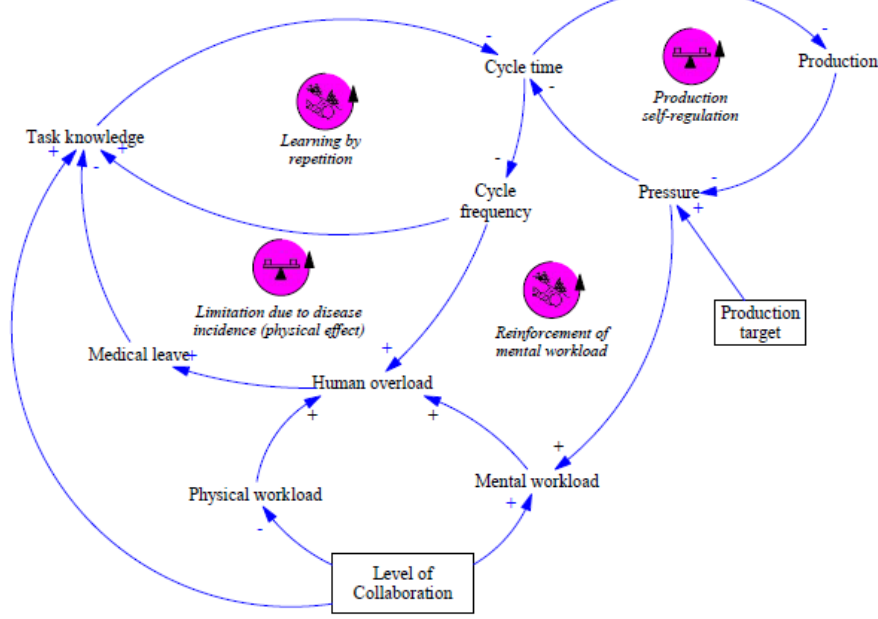
Figure 1. Causal Loop Diagram for an industrial HRC system.